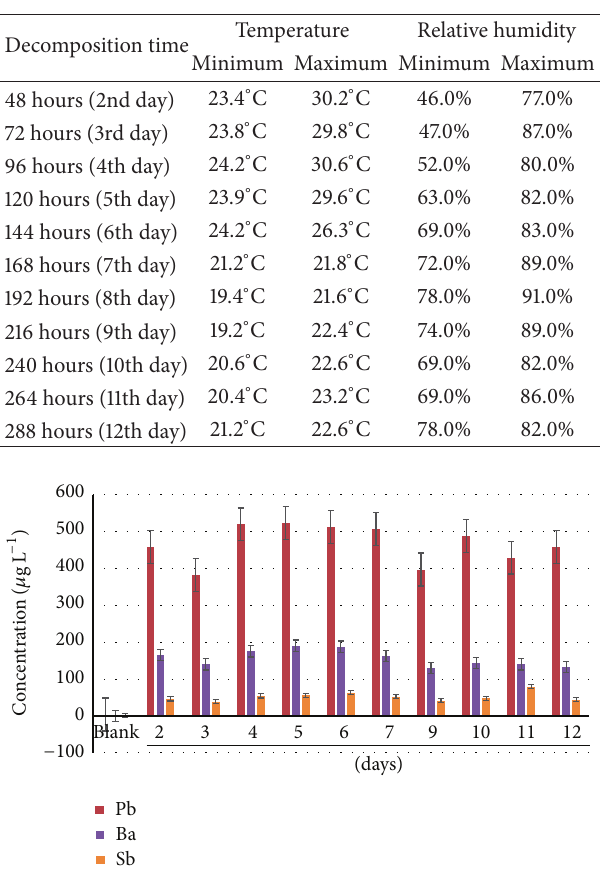
Table 3: Minimum and maximum temperature ( ∘ C) and relative humidity during the period of 2 to 12 days after the death of a female pig in decomposition, during the winter.